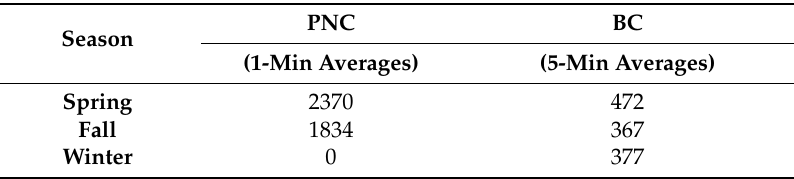
Table 1. Number of measurements collected during the study period. PNC BC Season (1-Min Averages) (5-Min Averages) Spring 2370 472 Fall 1834 367 Winter 0 377 PNC = particle number concentration, BC = black